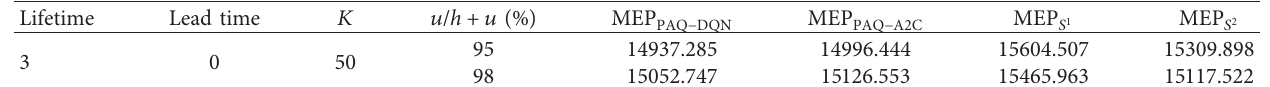
Table 10: MEP for new state forms.